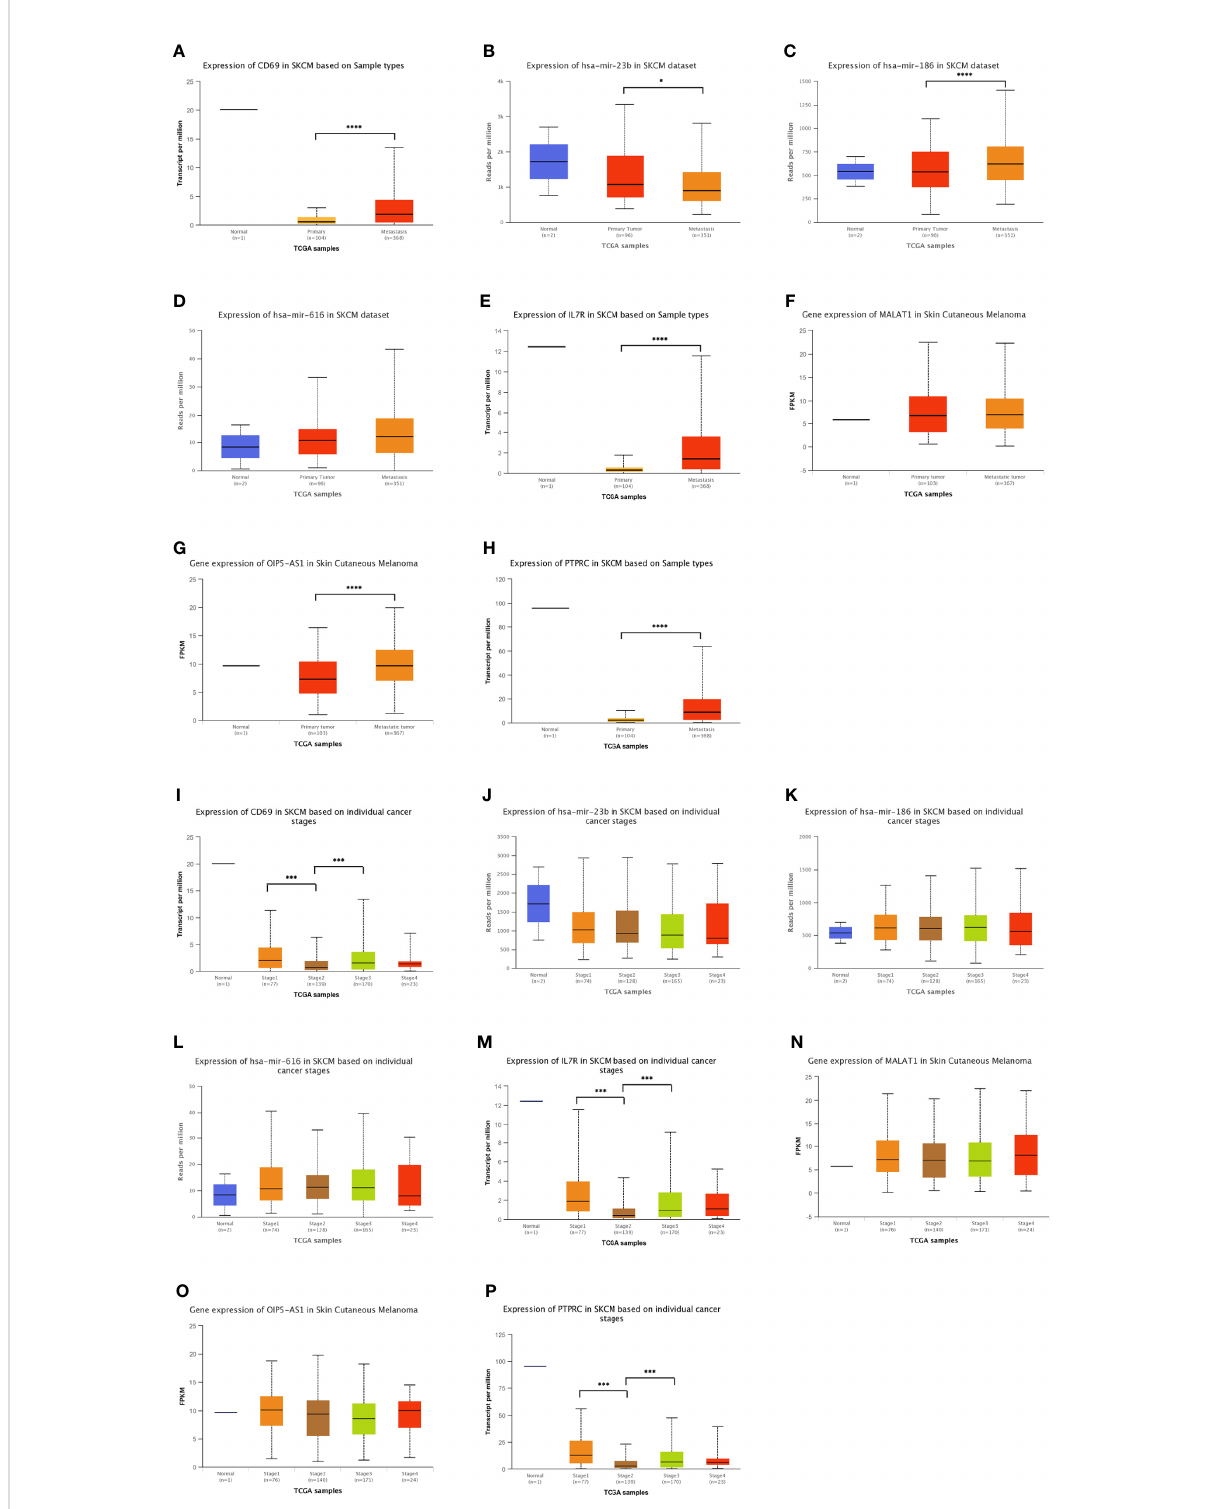
FIGURE 5 Distribution of the expression patterns of ten hub-genes in the triple regulatory network obtained from the UALCAN database. (A – H) The expression patterns of ten hub-genes in normal skin, primary SKCM, and metastatic SKCM datasets. (I – P) Expression patterns of the same hub- genes in tissue samples at different stages of SKCM. *p < 0.05, ***p < 0.001, ****p <